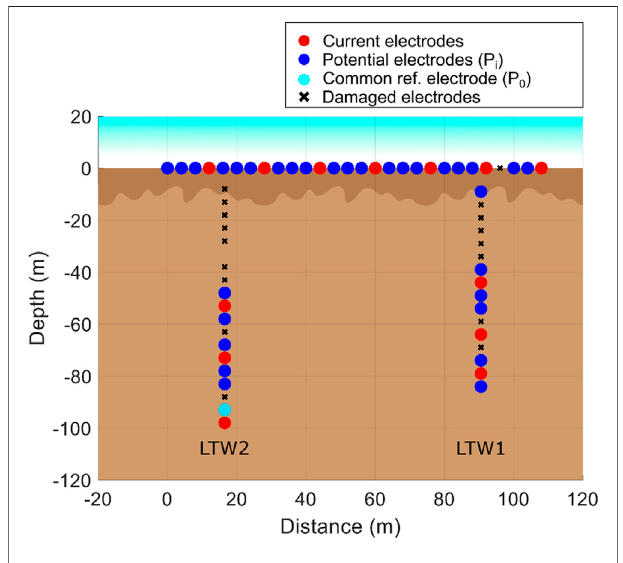
FIGURE 3 | Schematics of the surface and borehole ERT electrodes used in this study. Some electrodes (in cross symbols) were damaged by the lightning strikes. For the details on the electrode array, please refer to The layout of the electrode and geotechnical monitoring arrays .